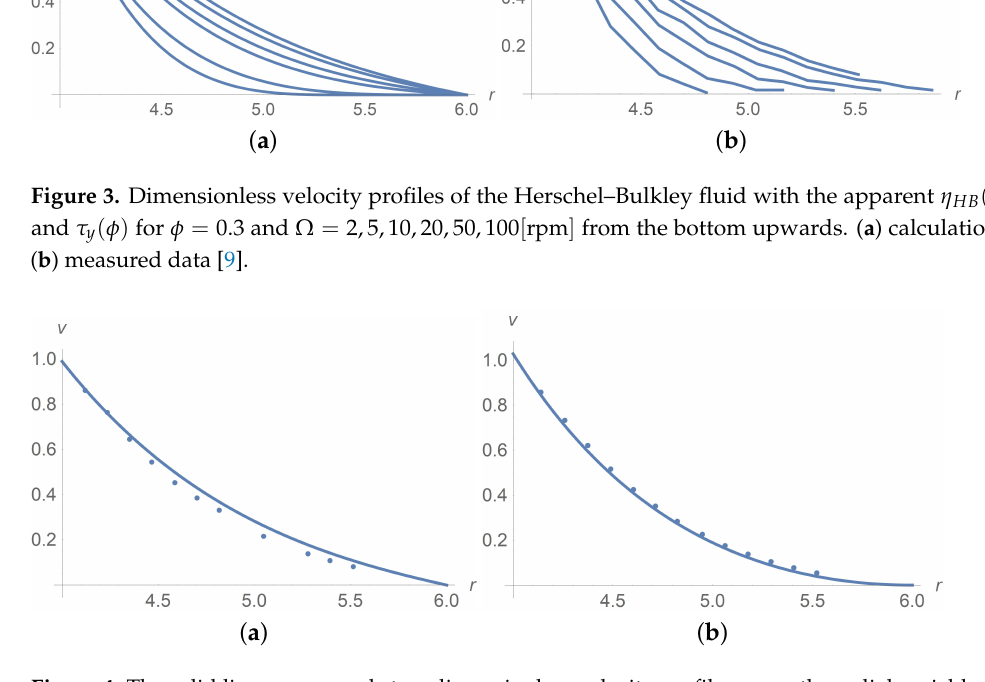
Figure 4. The solid line corresponds to a dimensionless velocity profile versus the radial variable for Ω = 100 [ rpm ] . Dots stand for experimental data [9]. ( a ) φ = 0.3, ( b ) φ = 0.1.